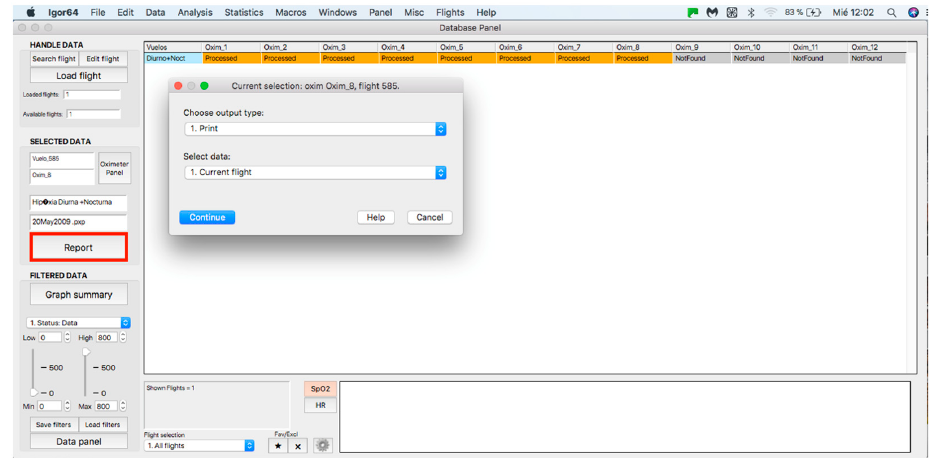
Figure 7. Panel to generate a printed report.